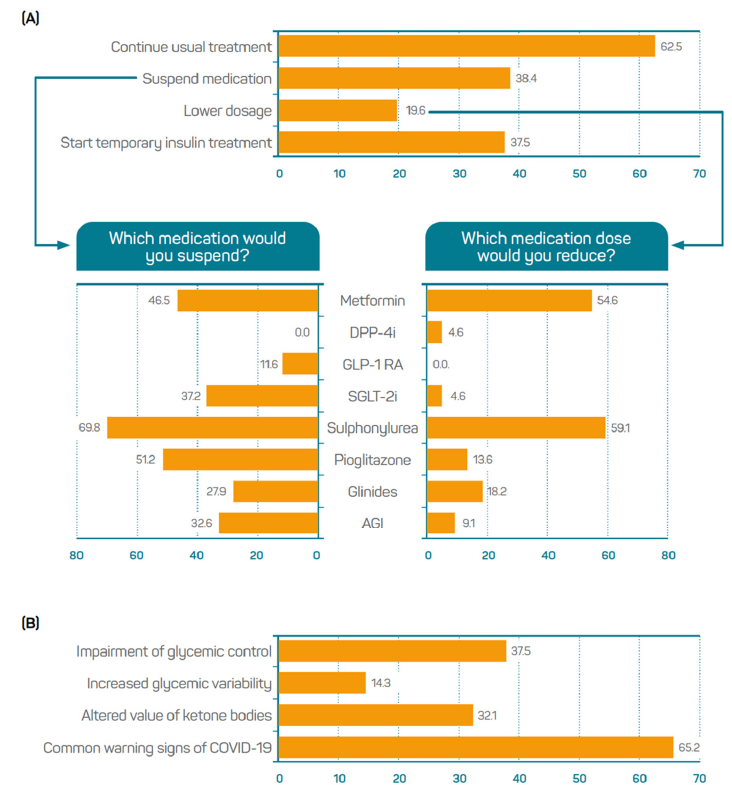
Figure 2. Opinion on management of ambulatory patients with T2DM and COVID-19: ( A ) therapeutic decisions made in these patients; ( B ) specific warning signs of T2DM to indicate hospital admission in these patients ( n = 112). AGI: Alpha-glucosidase inhibitors; DPP-4i, Dipeptidyl peptidase 4 inhibitors; GLP-1 RA, Glucagon-like peptide 1 receptor agonists; SGLT2i, Sodium-glucose transport protein 2 inhibitors.